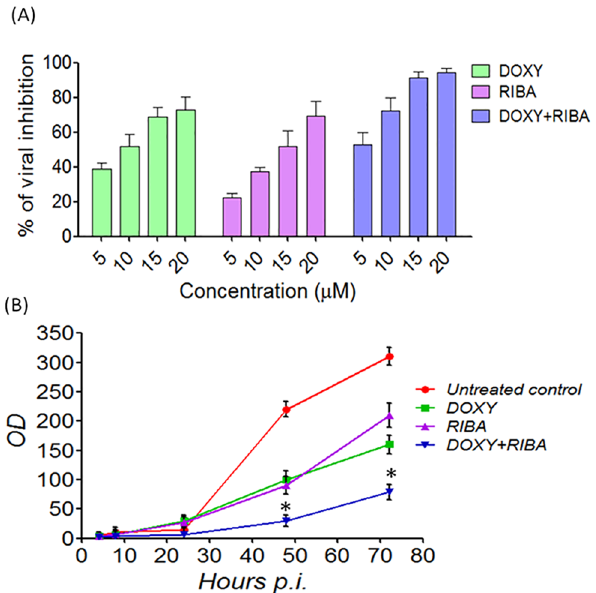
Fig 3. Inhibition of CHIKV after the treatment with DOXY, RIBA and DOXY+RIBA. (A) ELISA-like cell- based assay was used to evaluate the antiviral activity of the drugs. Viral antigen was detected by CHIKV antibody and anti-mouse IgG conjugated with alkaline phosphatase. The 50% effective concentration (EC 50 ) of the DOXY was calculated to be 10.95 ± 2.12 μ M and the RIBA drug was 15.51 ± 1.62 μ M, while DOXY+RIBA (1:1) showed an EC 50 of 4.52 ± 1.42 μ M. (B) Levels of viral proteins after the treatment with drugs were measured by ELISA-like cell-based assay of triplicates at 4, 8, 24, 48 and 72 h post infection. The OD values were measured by an ELISA reader at 490 – 650 nm. The result showed considerable improvement on performance when the test compound were administered together compared to individual treatment (Two way ANOVA, * P <